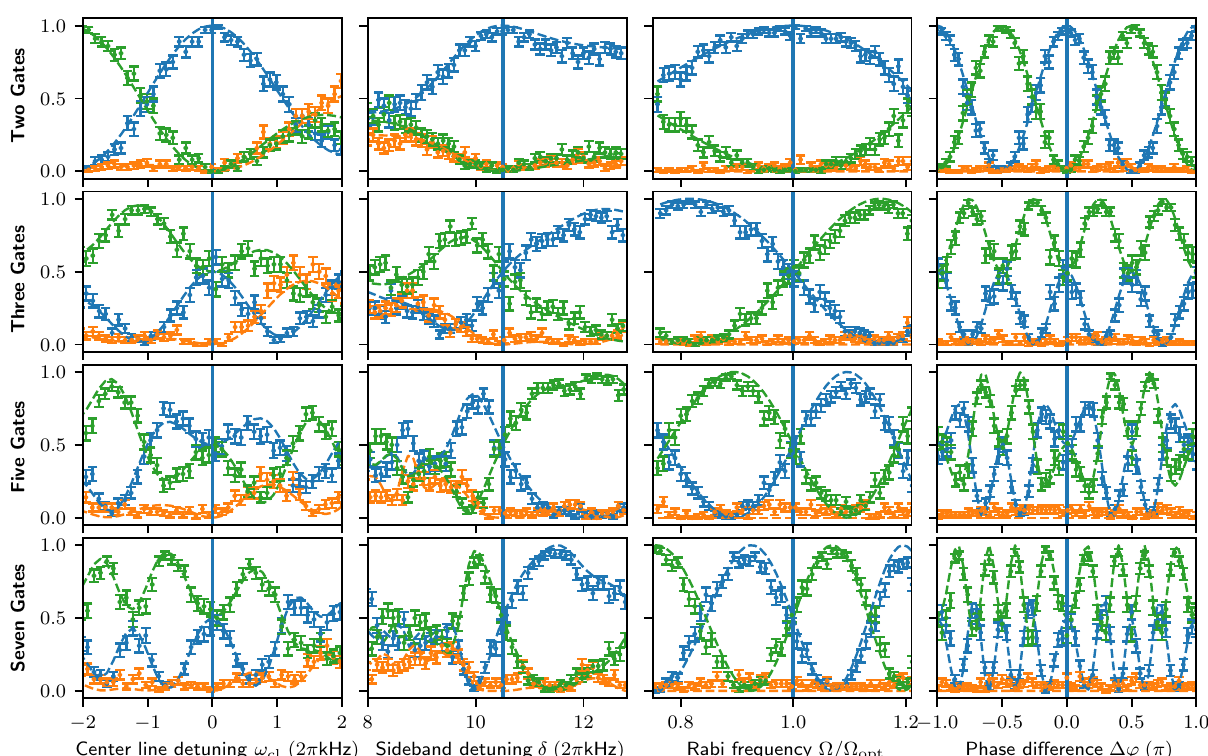
FIG. 2. Populations of | g , g (cid:3) (green), of | e , e (cid:3) (blue), and of | e , g (cid:3) and | g , e (cid:3) (orange) after the application of two, three, five, and seven gates with varying control parameters. For each scan, the other parameters have been held constant at the optimal value for the MS gate. The error bars are estimated from shot noise. Dashed lines indicate the numerical simulations. The vertical lines mark the target value for each